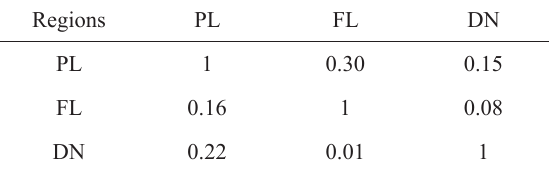
Spearman correlation above the diagonal and the Pearson below the diagonal from the uni-characteristic analyses.